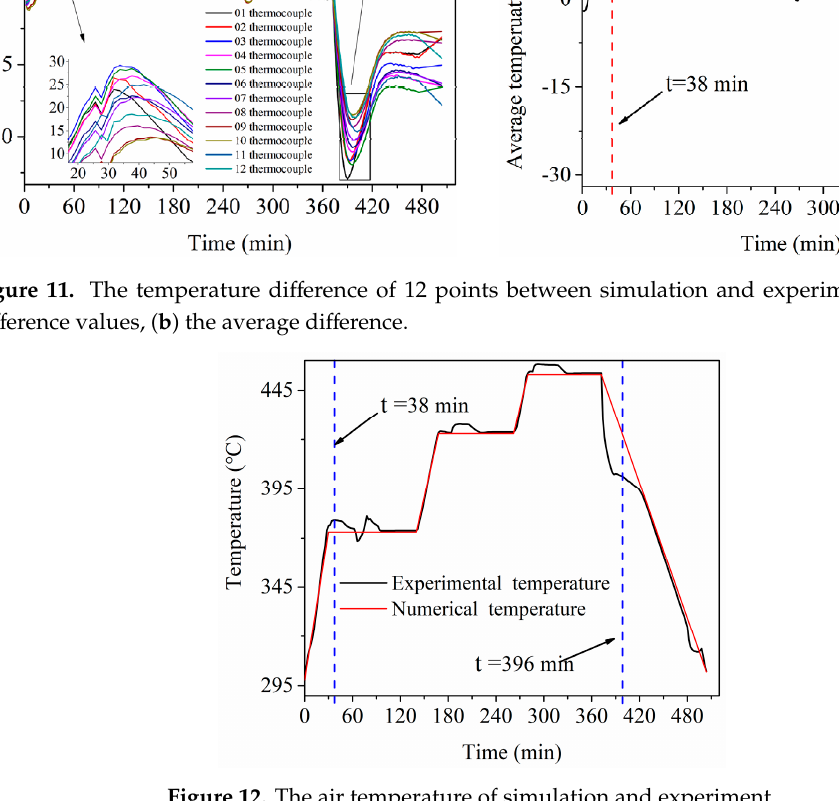
Figure 11. The temperature difference of 12 points between simulation and experiment. ( a ) The difference values, ( b ) the average difference.